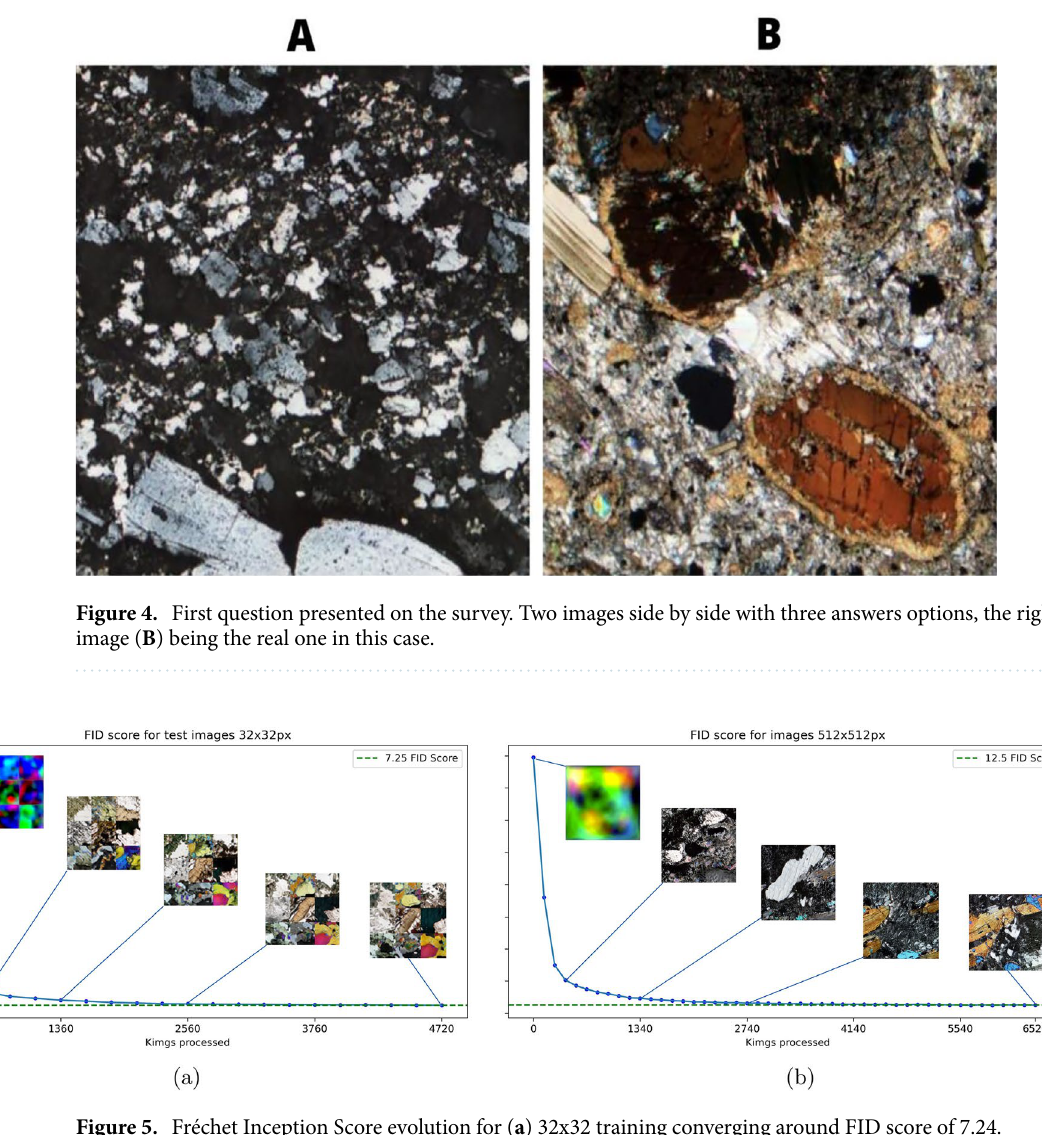
Figure 5. Fréchet Inception Score evolution for ( a ) 32x32 training converging around FID score of 7.24. A 3 × 3 grid of image evolution during training, and ( b ) evolution of FID Score for the 512x512 primary training converges around FID score of